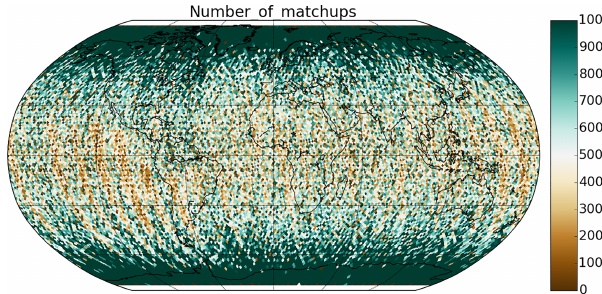
Figure 2. Total number of CALIPSO-CALIOP matchups with NOAA-18 and NOAA-19 AVHRR observations in the time period October 2006 to December 2015. Results are presented in a Fi- bonacci grid with 75km resolution.